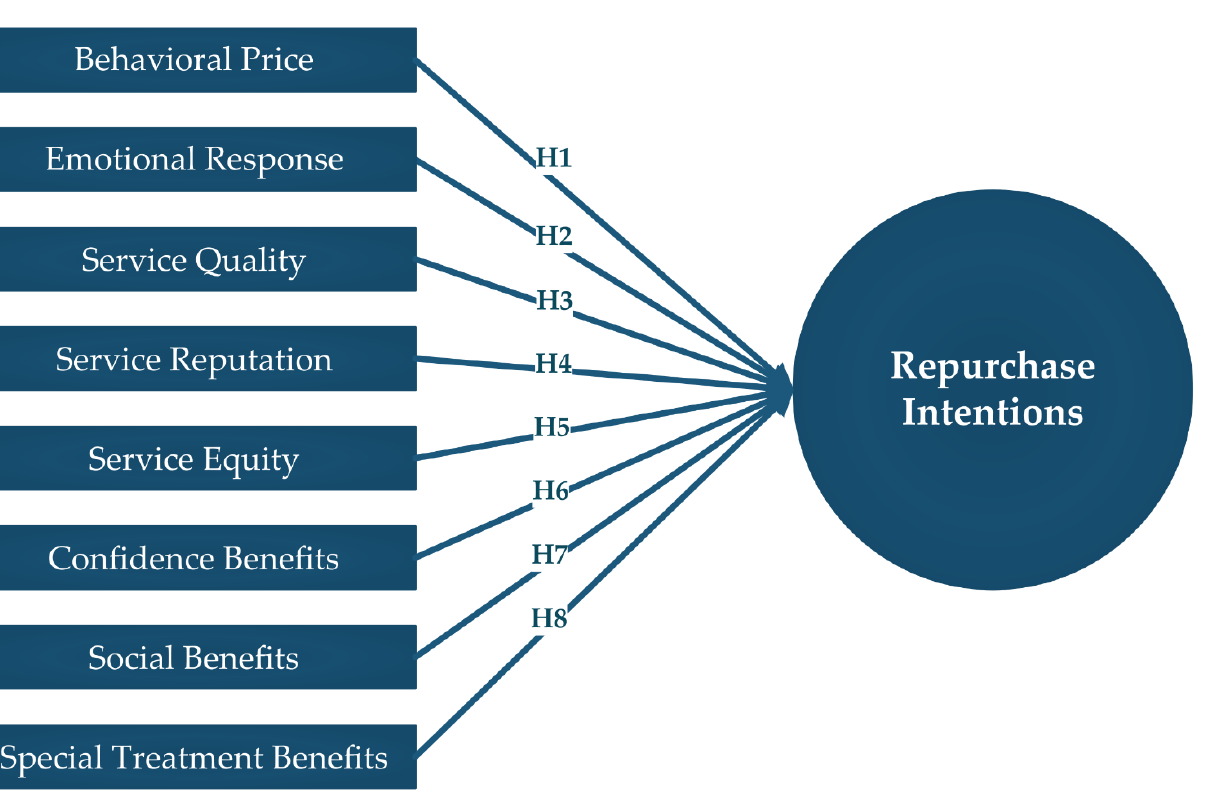
Figure 1. The conceptual framework.